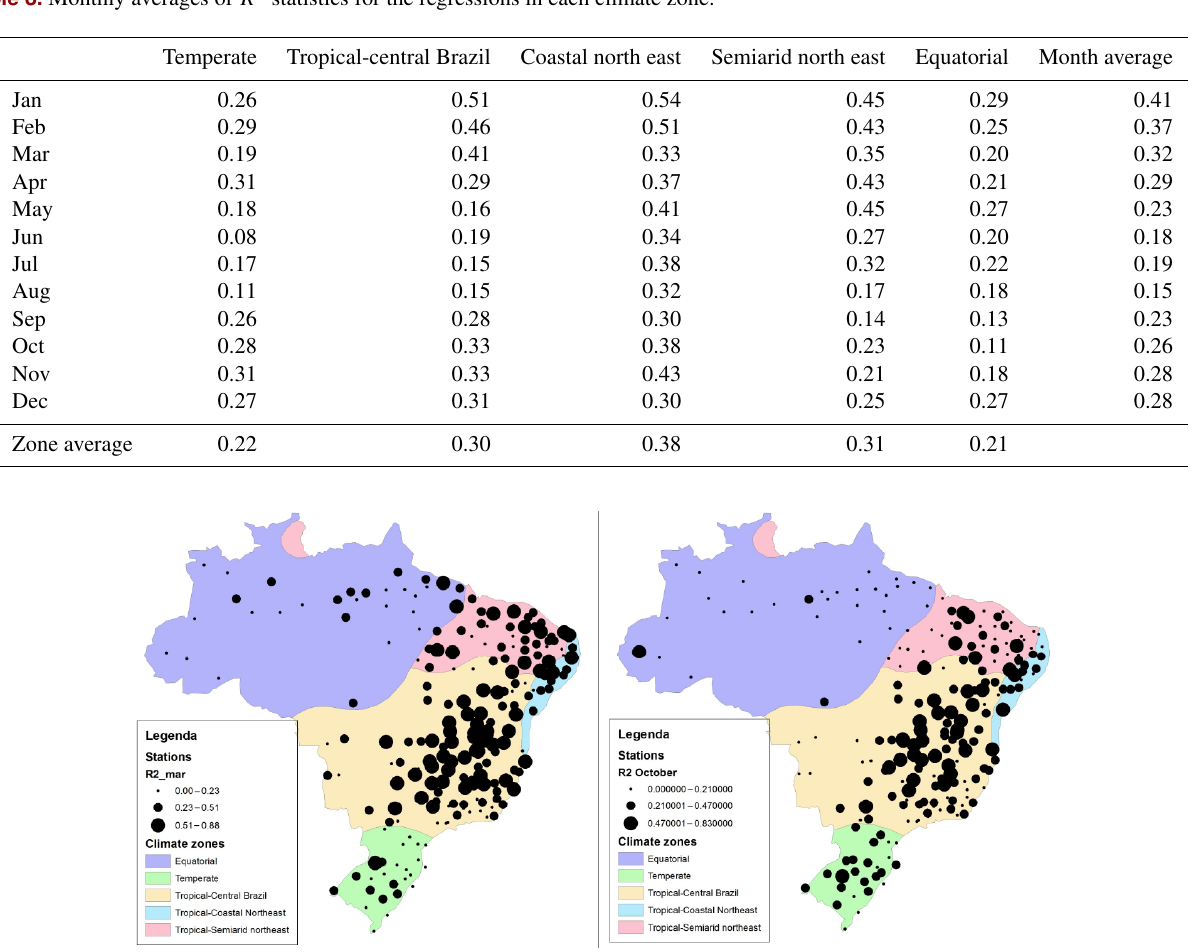
Figure 2. Spatialized values of R 2 statistic for transition months: March (left) and October